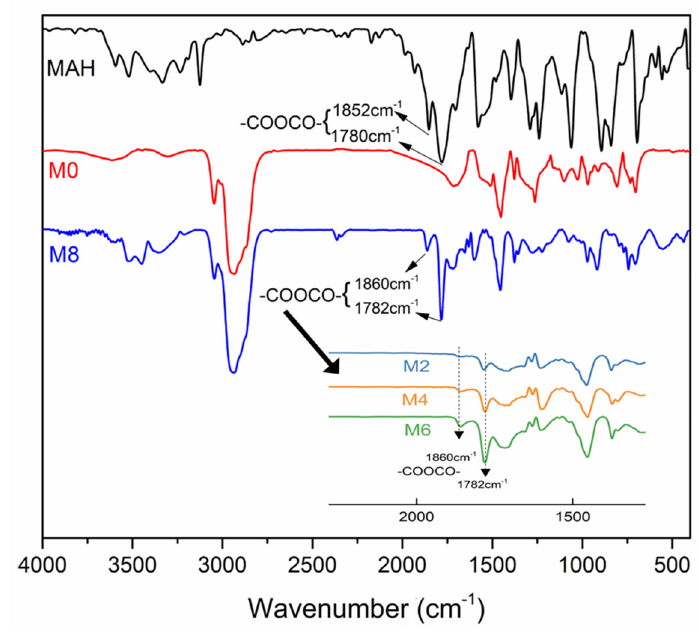
Figure 2. FTIR spectra of maleic anhydride (MAH), DCPD resin and M-DCPD resin.